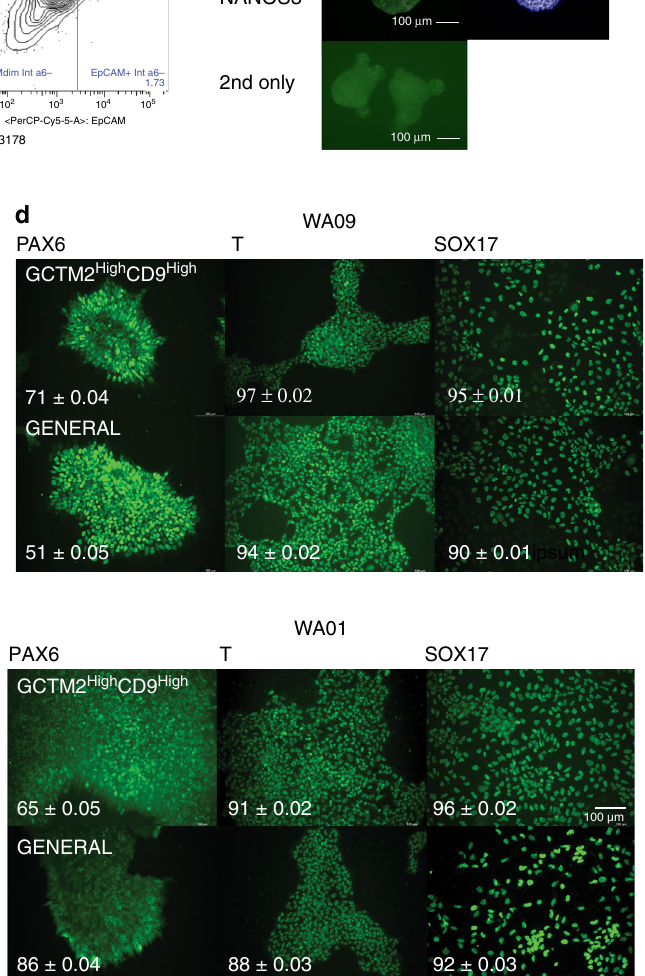
exhibiting higher rates of oxidative phosphorylation and anabolic amino acid and lipid synthesis. DNA methylation in hPSC cultured under de fi ned conditions . Levels of DNA methylation in the mouse and human epiblast are low, but increase substantially in the mouse following embryo implantation and activation of the de novo methyltransferases Dnmt3a and Dnmt3b 34,35 . Reduced representation bisul fi te sequencing to assess levels of DNA methylation showed no major differences between the relatively low mean levels of overall DNA